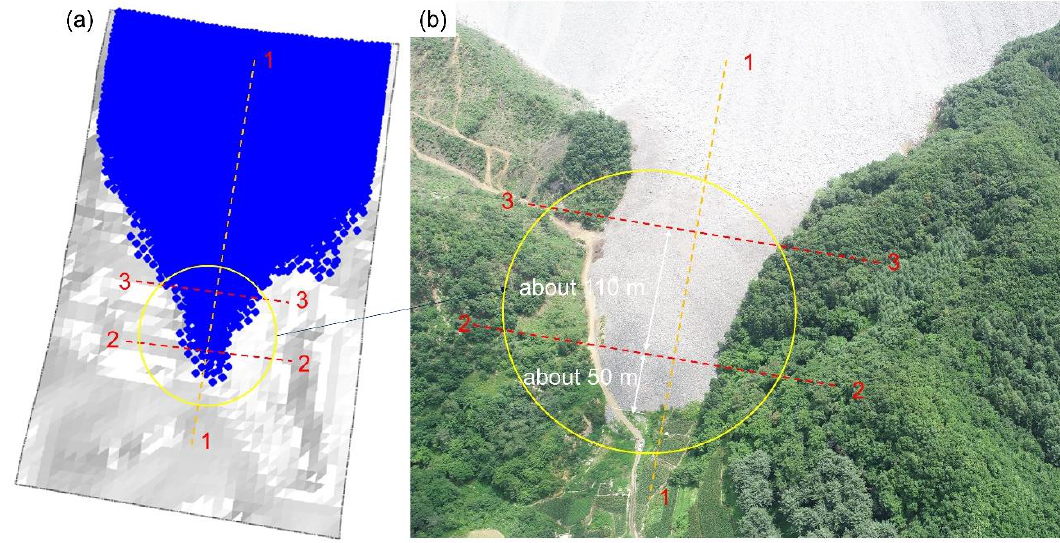
Figure 13. Sections 1–1, 2–2 and 3–3 at different positions of ( a ) the SPH model and ( b ) the actual landslides.